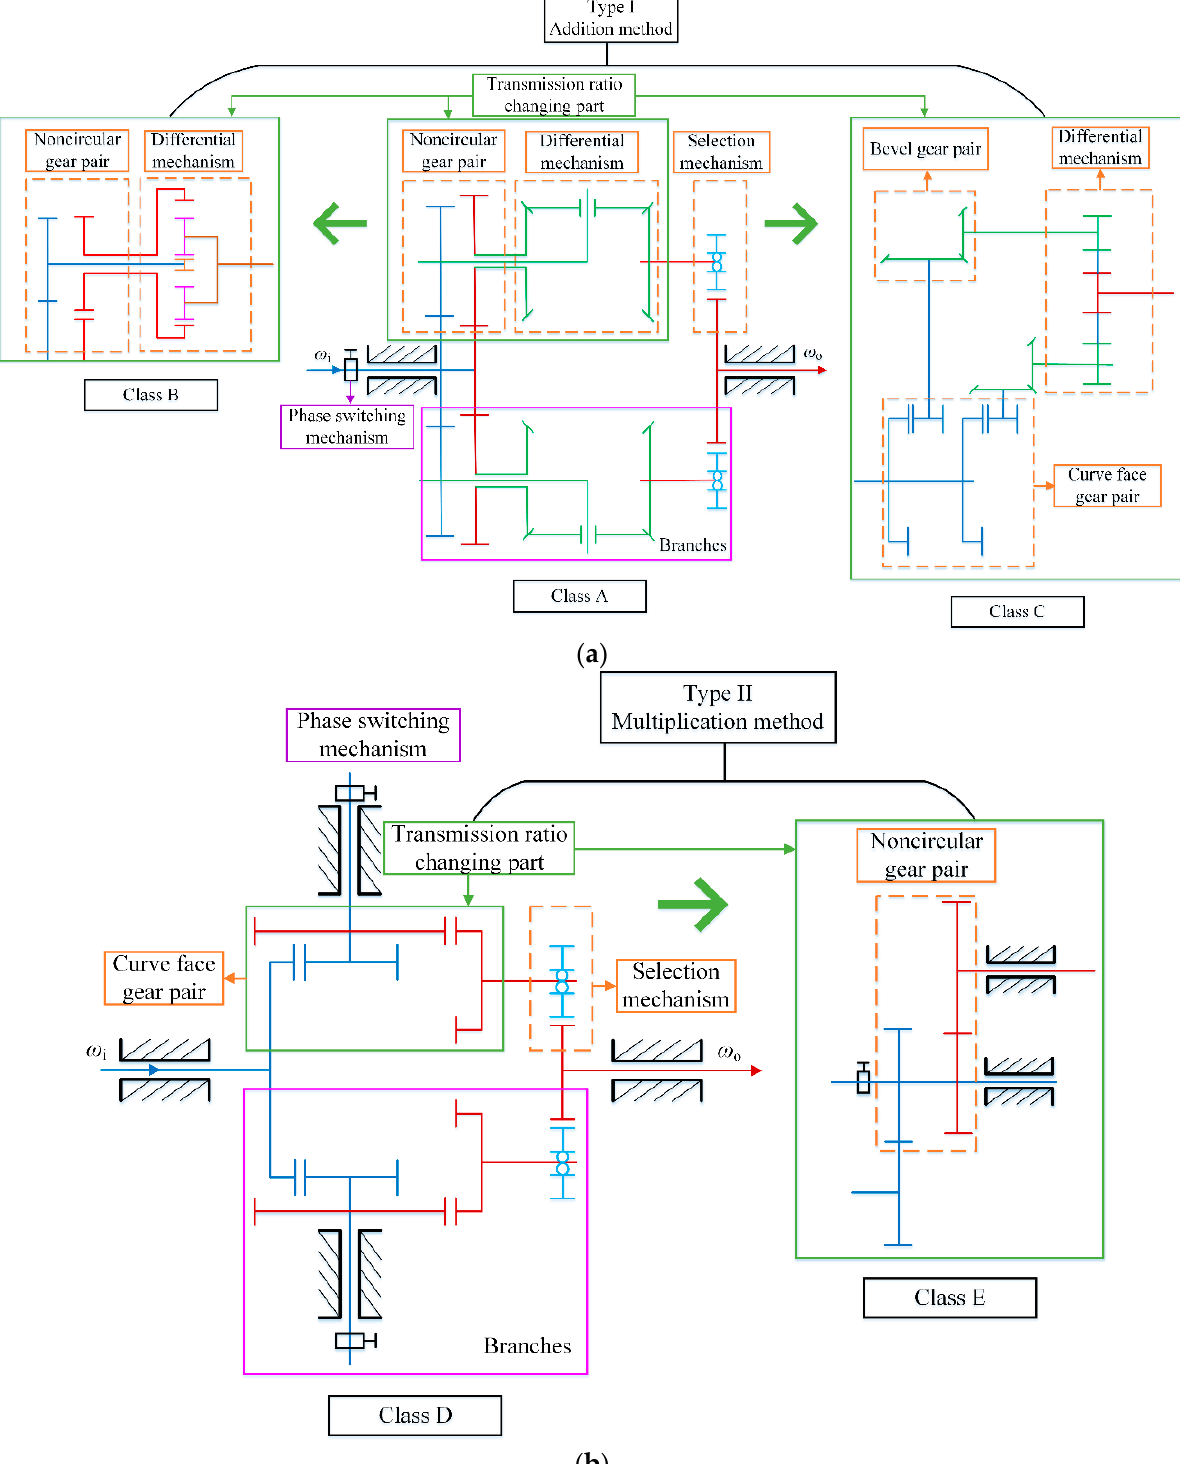
Figure 2. CVT pattern of spatial noncircular gear. ( a ) Type I: Addition method. ( b ) Type II: Multiplication method.